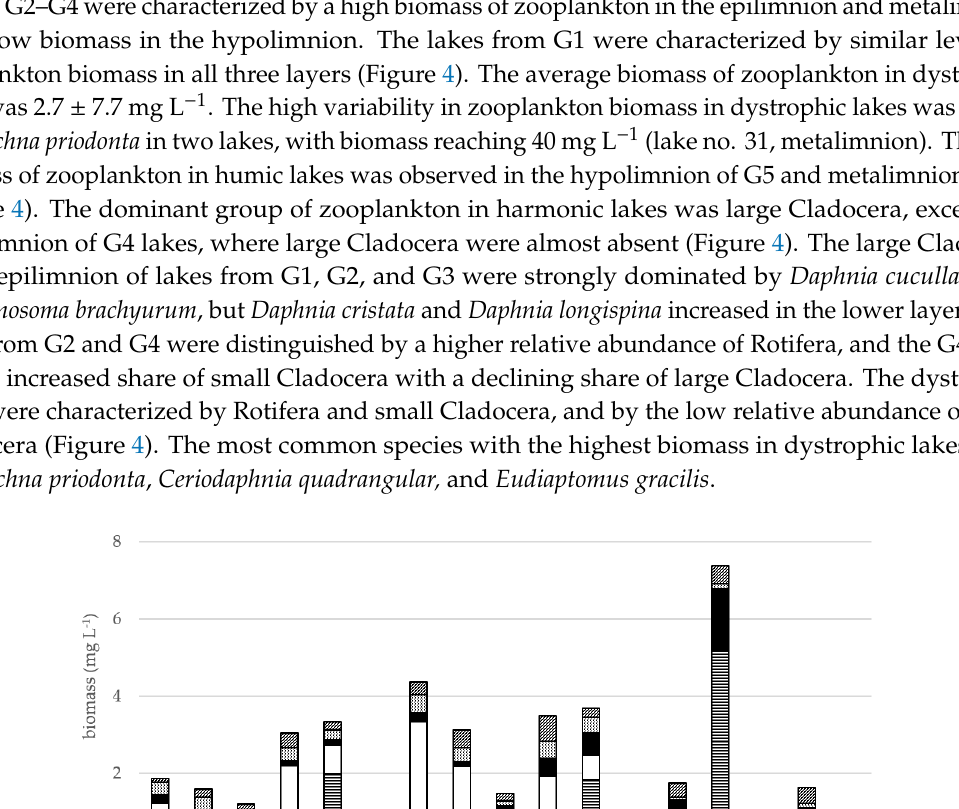
Figure 4. The mean biomass of zooplankton in vertical profiles of lakes with di ff erent oxygen conditions. The first axis of the CCA ordination was the most important, contributing to 70.43% of the inertia, and represented the di ff erence between the zooplankton communities in dystrophic lakes (positively related to F1) and harmonic lakes (negatively related to F1). The CCA analysis also